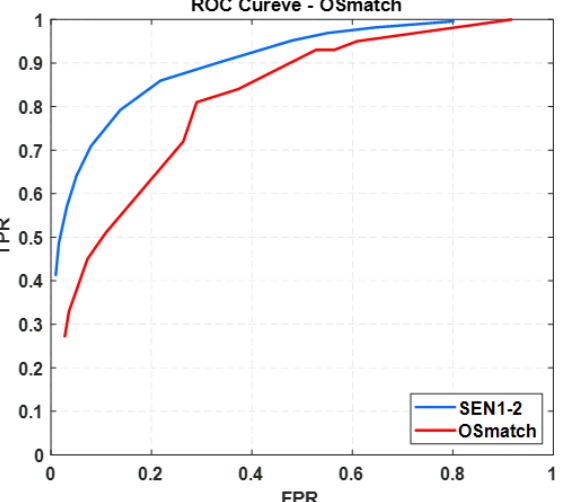
Figure 10. ROC curves deliverd on OSmatch